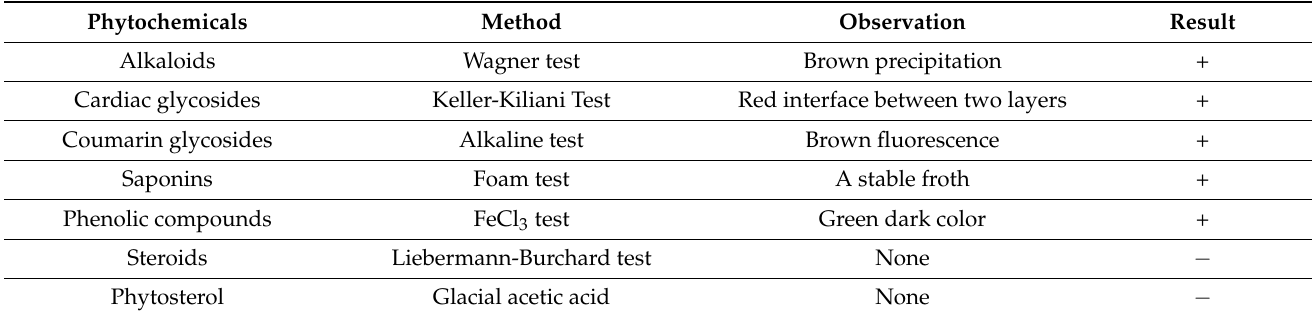
Table 1. Screening phytoconstituents in aqueous Cordyline terminalis Kunth leaf extract. Phytochemicals Method Observation Result